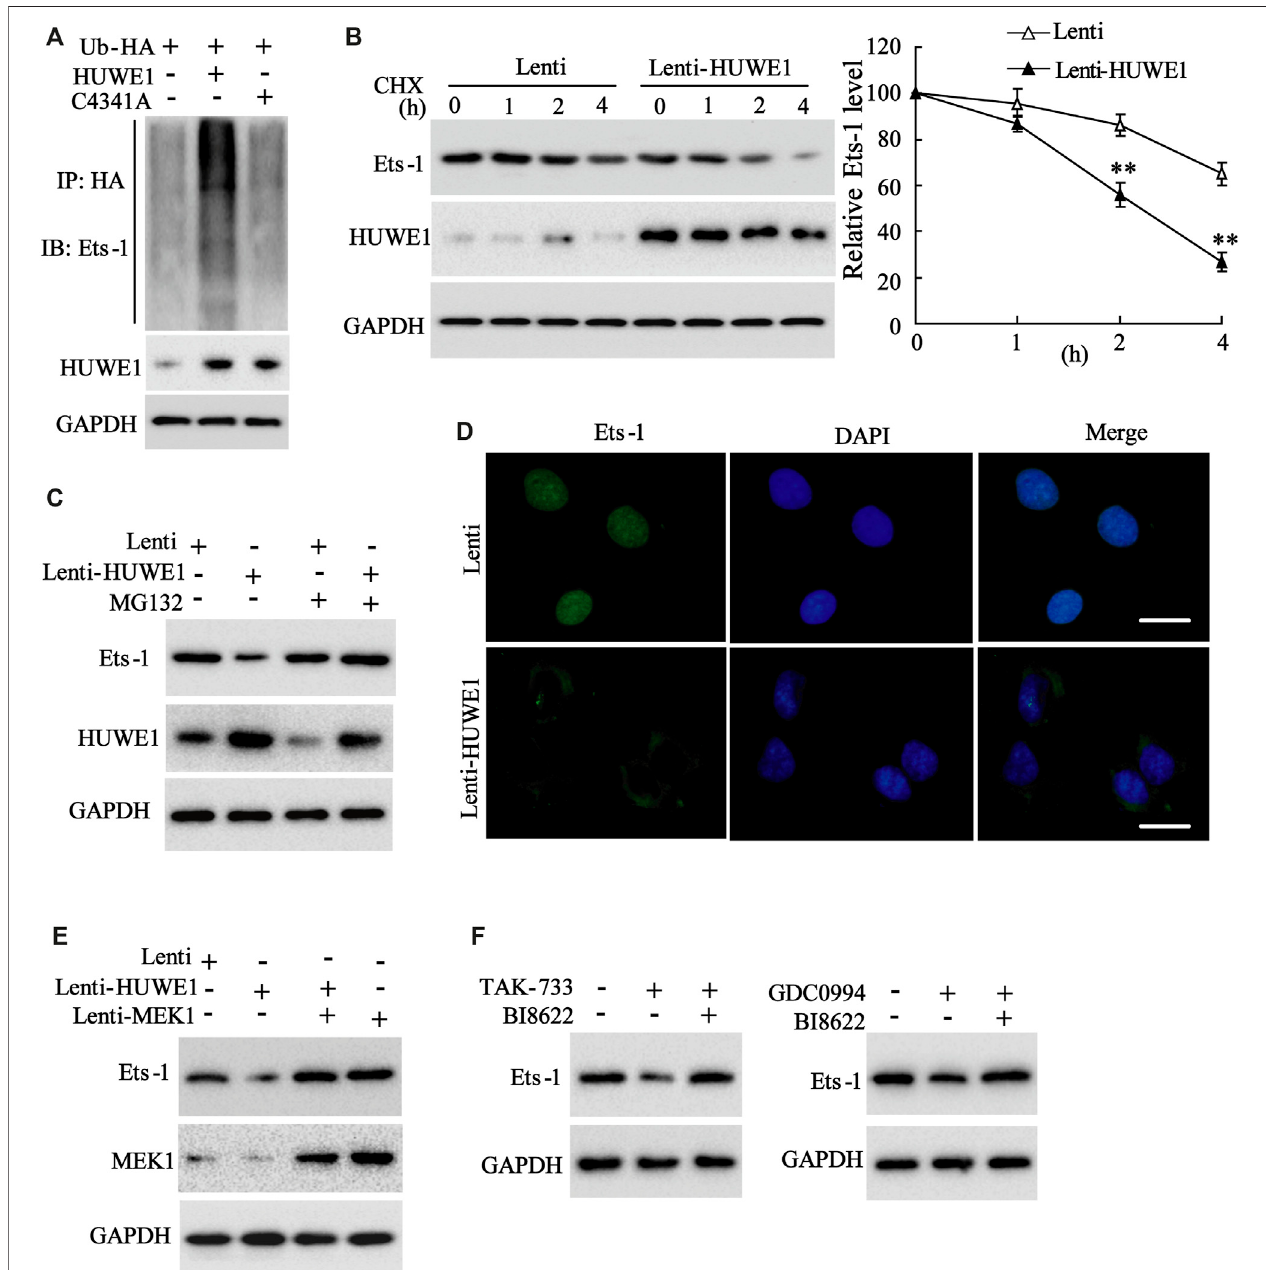
FIGURE5| In fl uence ofHUWE1 onthe ubiquitination and degradation ofEts-1 protein. (A) Jurkat Tcellsweretransfected withHb-HA and Lenti-HUWE1 or Lenti- HUWE1C4341A, respectively.Ubiquitin experiment was conducted to assess the ubiquitination of Ets-1. (B) Jurkat T cells were transfected with Lenti-HUWE1 for 48 h and then were treated with 50 mmol/L CHX for 0, 1, 2 and 4 h. Western blot was performed to measure the protein levels of Ets-1 and HUWE1. (C) Jurkat T cells were transfectedwithLenti-HUWE1for48 handthenweretreatedwith10 μ mMG1324 hbeforethesampleharvesting. Westernblotwasappliedtodetecttheprotein level of Ets-1 and HUWE1. (D) Jurkat T cells were transfected with Lenti-HUWE1 for 48 h. An immuno fl uorescence assay was conducted to analyze the expression of Ets-1 and the nuclear export of Ets-1 (scale bar: 10 μ m). (E) Jurkat T cells were transfected with Lenti-HUWE1 and/or Lenti-MEK1. Western blot was applied to detect the protein levels of Ets-1 and MEK1. (F) Jurkat T cells were treated with TAK-733 (1 μ M) and/or HUWE1 speci fi c inhibitor BI8622 (1 μ M), GDC0994 (1 μ M) and/or BI8622 (1 μ M). Western blot was performed to detect the protein level of Ets-1. ** p < 0.01 vs. Lenti. The experiment was repeated three times. CHX: cycloheximide.